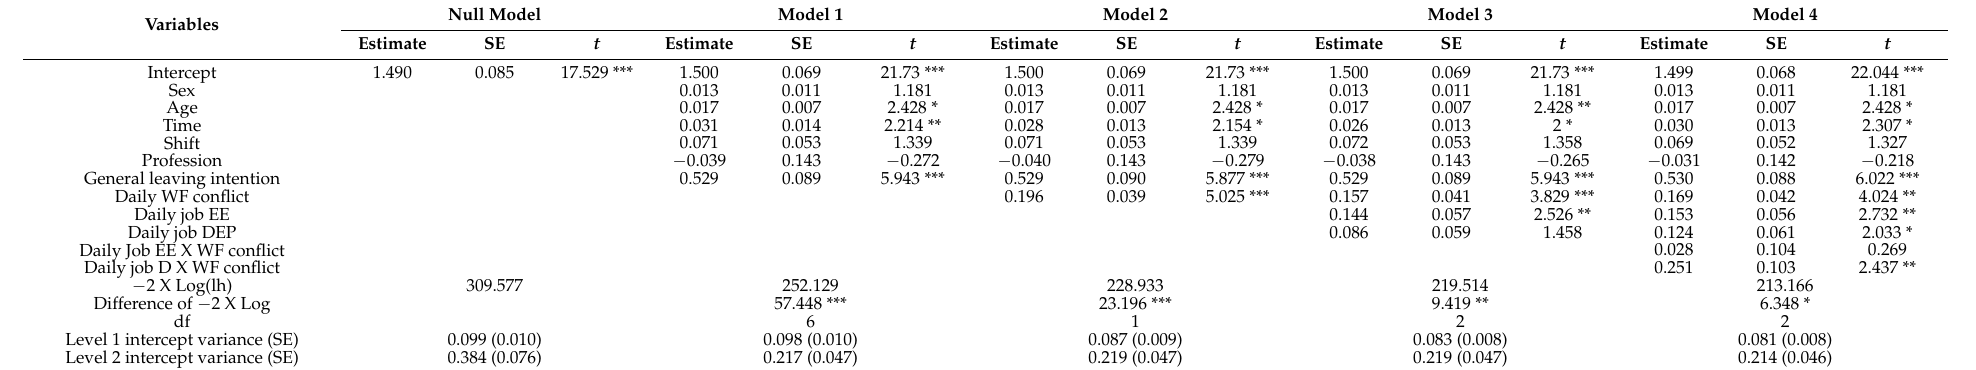
Table 2. Multilevel estimates for models predicting daily leaving intentions ( N = 56 × 5 days = 280 statistical